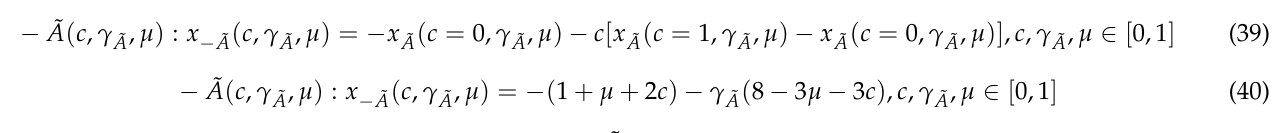
Figure 19. Foot-print of uncertainty FOUSP ˜ adding two T2FNs ˜ A + ˜ B = ˜ C